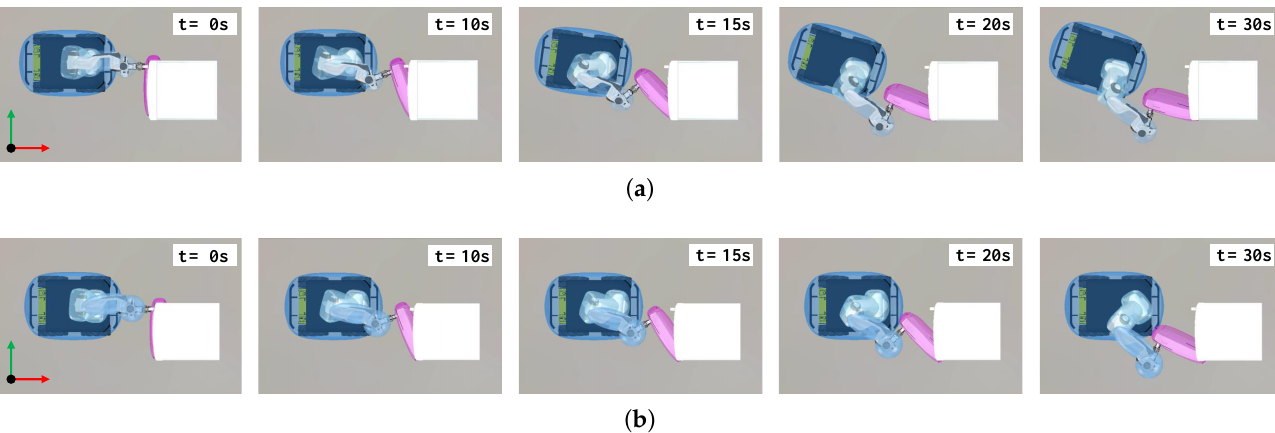
Figure 17. Simulation results of opening a refrigerator. ( a ) Snapshots of opening a refrigerator with obstacle avoidance; ( b ) snapshots of opening a refrigerator without obstacle avoidance.